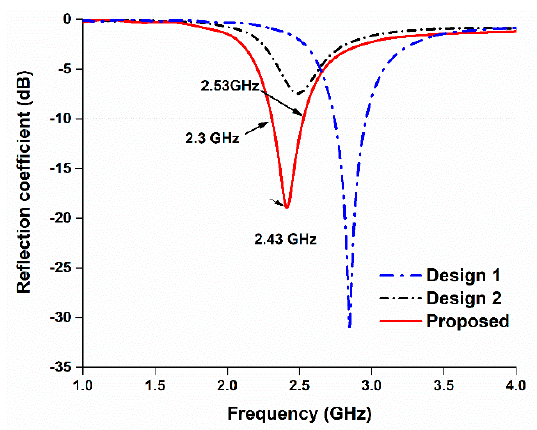
Figure 2. Reflection coefficients of the antenna.